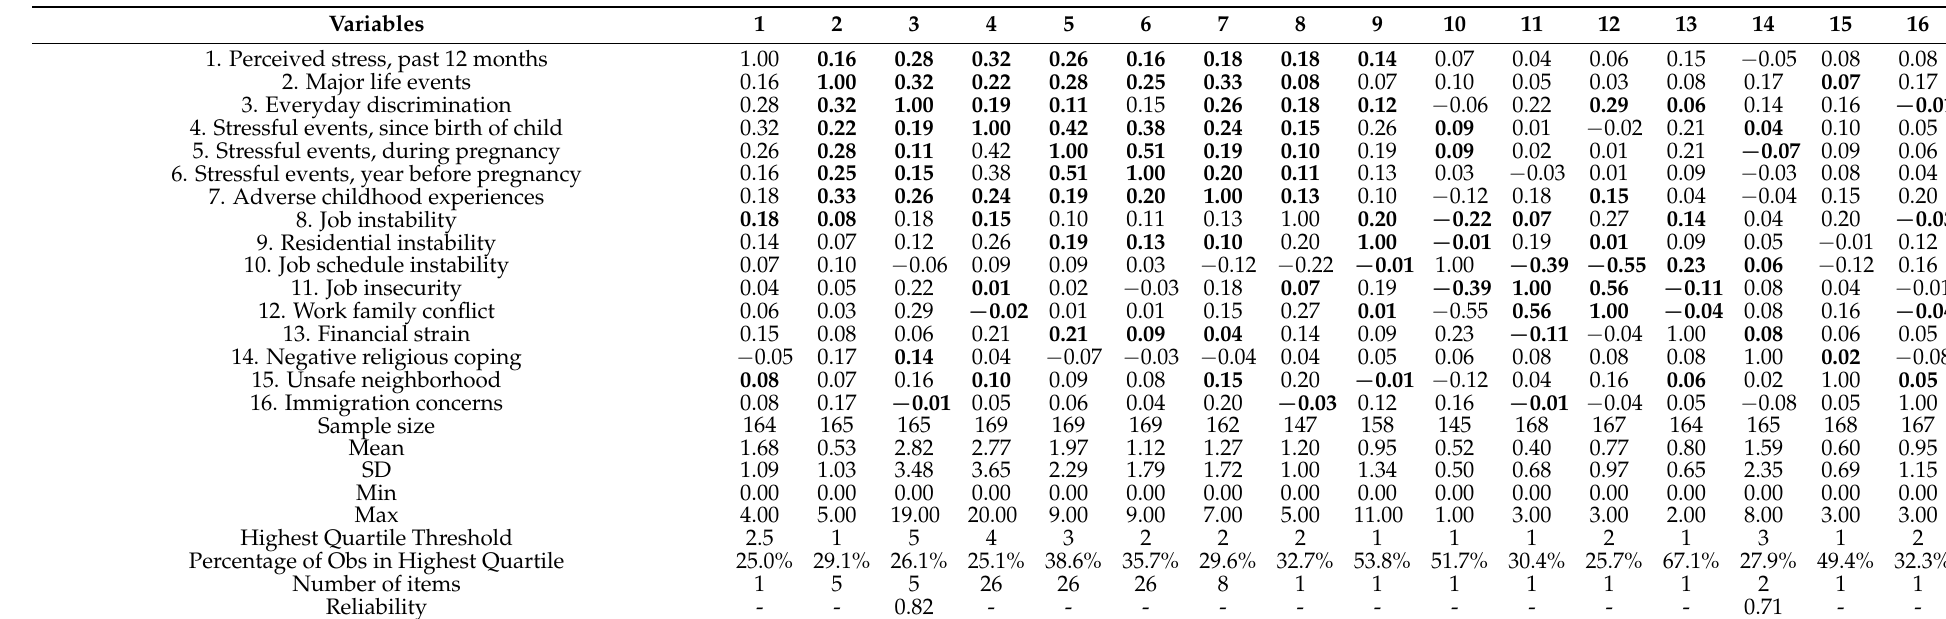
Table A1. Correlation and Descriptive Statistics for Stressor Measures, original data (prior to multiple